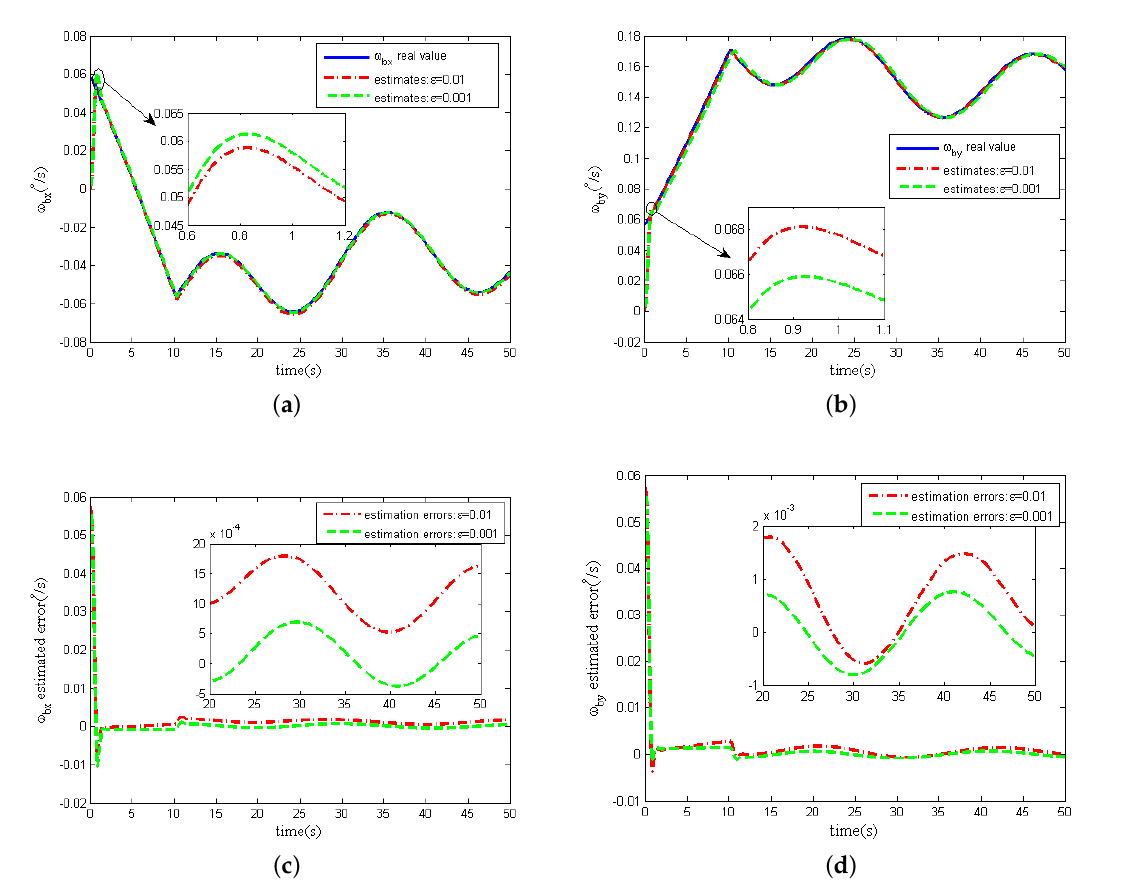
Figure 6. Estimation of spacecraft angular rates without measurement noise. ( a ) x-axis angular rate ω bx ; ( b ) y-axis angular rate ω by ; ( c ) ω bx estimation error; ( d ) ω by estimation